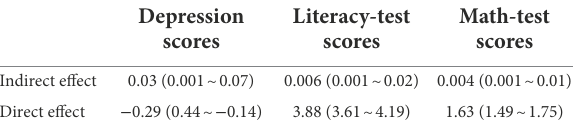
The figures in the table are the mediation effect coefficient and bias-corrected 95%